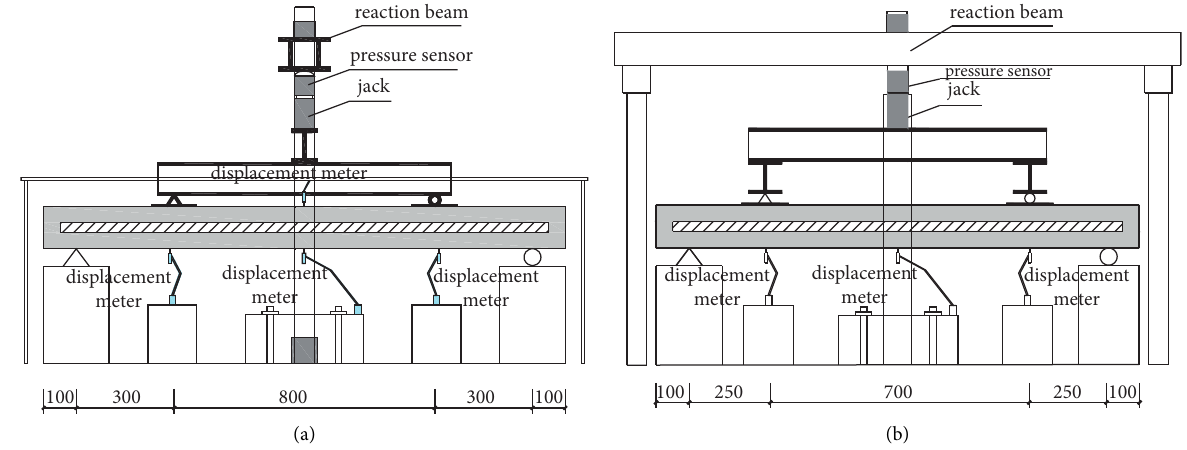
Figure 3: Schematic diagram of the test device: (a) the front view; (b) the side view.